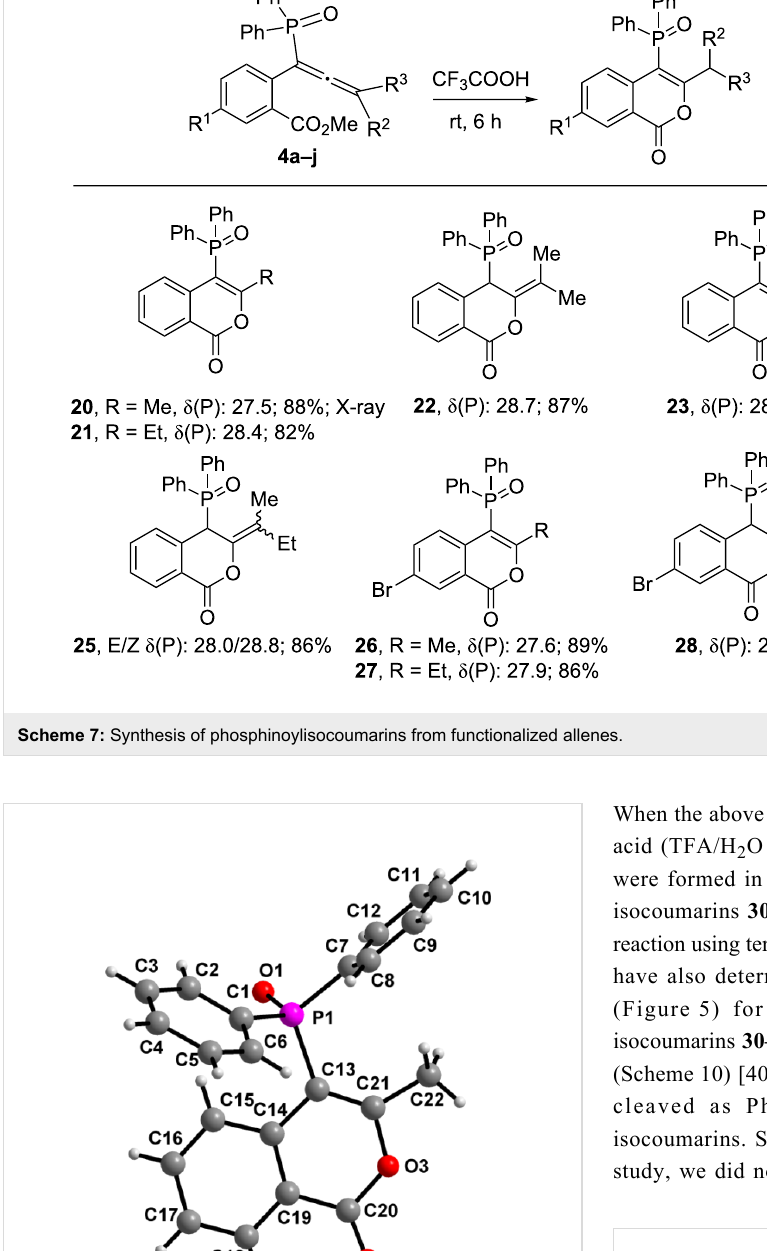
Figure 4: Molecular structure of 20 . Selected bond lengths [Å] with estimated standard deviations are given in parentheses: O3–C21 1.386(2), C21–C22 1.486(3).